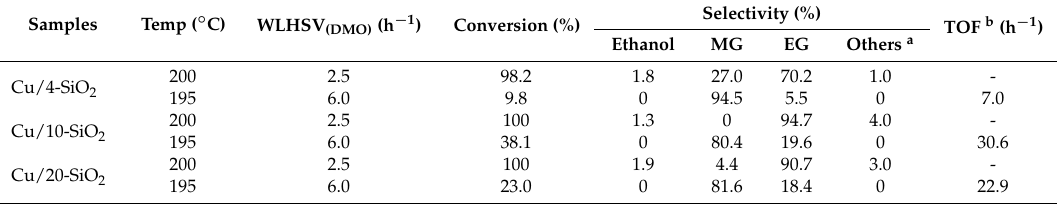
Table 3. Catalytic performance of Cu/ x -SiO 2 ( x = 4, 10, 20) for dimethyl oxalate (DMO)